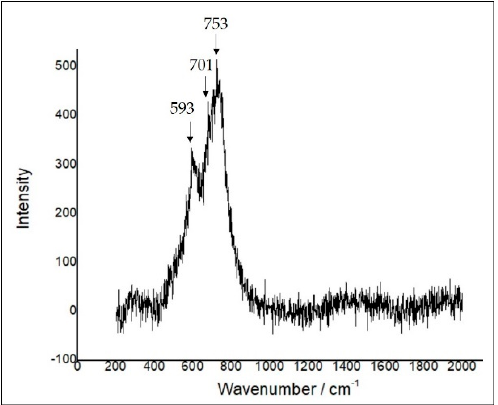
Figure 7. Raman spectrum, measured at 5 mW laser power, of hercynite spinel inclusion in sapphire (sample KN43) from Krong Nang.